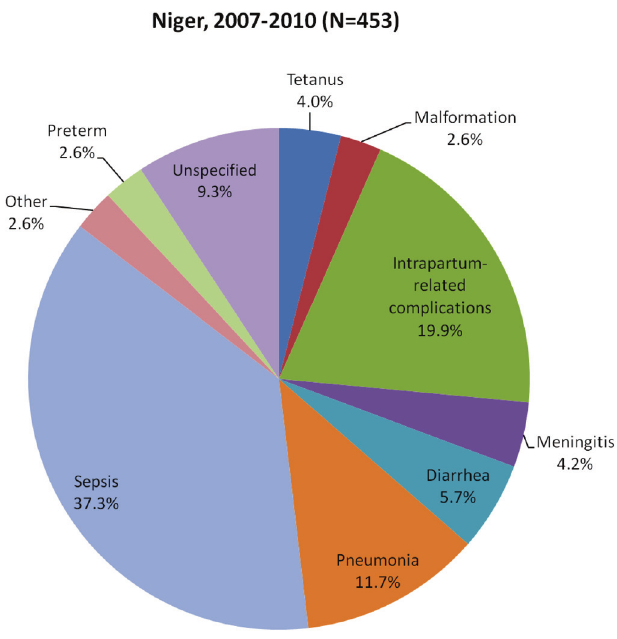
Figure 1. Expert algorithm, hierarchical verbal autopsy causes of death for 453 neonatal deaths, Niger,